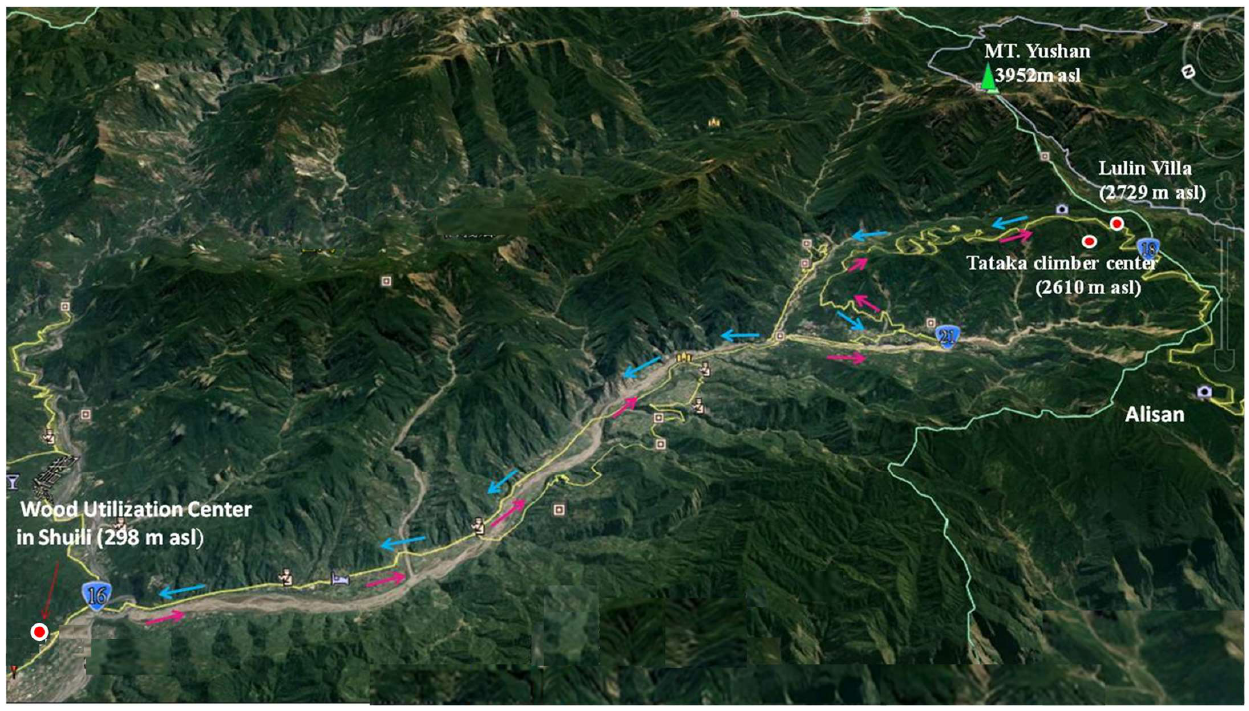
Figure 1. Route map of forest travel from low to high altitude Participants took a medium-sized bus following the altitude change from Shuili town at altitude 298 m. The travel time was 1.5 h to reach Tataka climber center at alti- tude 2610 m. Participants arrived at Tataka climber center and took 20 min to rest. Then, we began the first CVFs and SpO 2 examination (between 9:41 a.m. to 10:18 a.m.) for par- ticipants at Tataka climber center. After completing the examination, they traveled 18 CVFs and SpO 2 examination at 11:06 a.m. on arrival at Lulin villa. They rested at the after resting for 60 min. After that, participants came back to the starting point at Tataka climber center and underwent the second CVFs and SpO 2 examinations at 12:46 p.m., with about a 2 h interval between the first to second examinations. After completing the